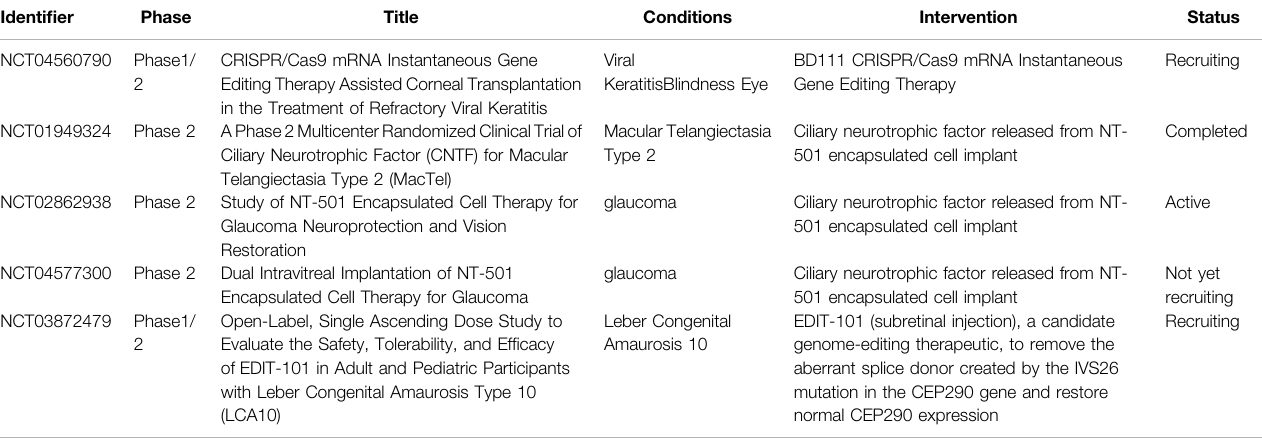
TABLE 1 | Clinical trials investigating human genome editing for ocular diseases. Target means the diseases targeted in ophthalmology. Strategy means the experimental process by genome editing to treat the targeted disease. Identi fi